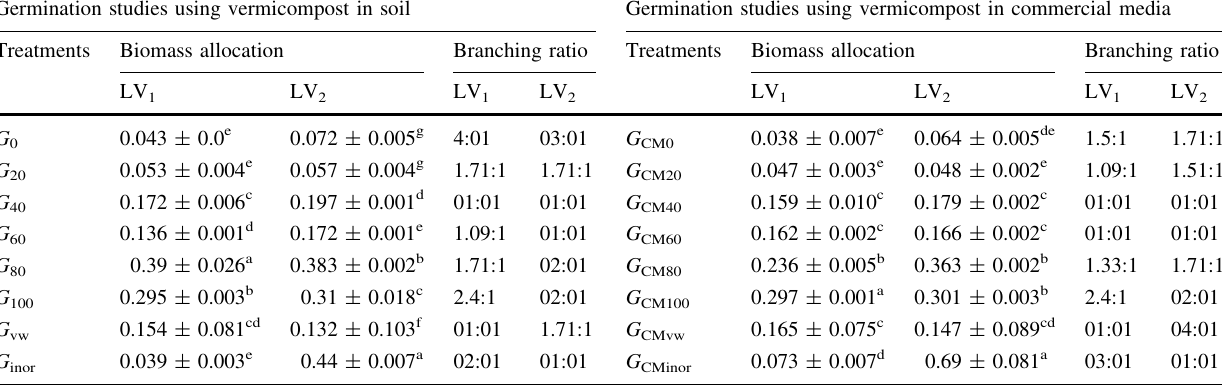
Table 7 Comparison of seedling performance in terms of biomass allocation and branching ratios in two varieties of Linum LV 1 and LV 2 in different treatments Germination studies using vermicompost in